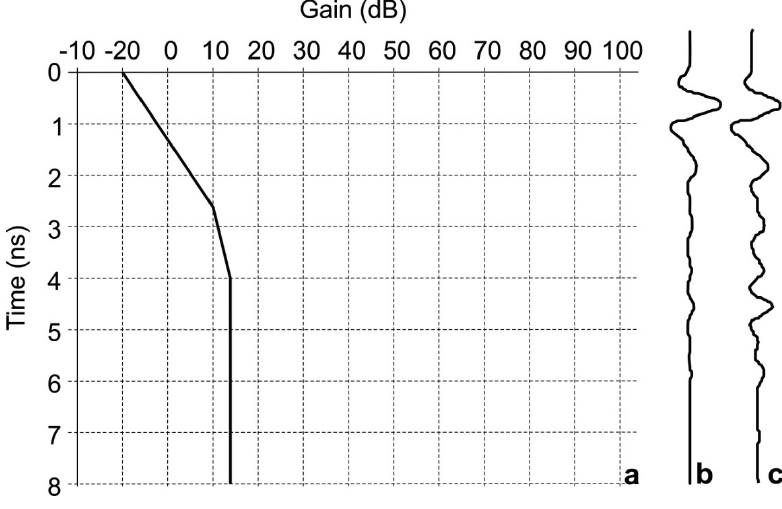
Figure 3. Amplification of radar amplitudes: gain function. ( a ) The three-point manual gain function applied to all traces; ( b ) original A-scan; ( c ) A-scan after gain